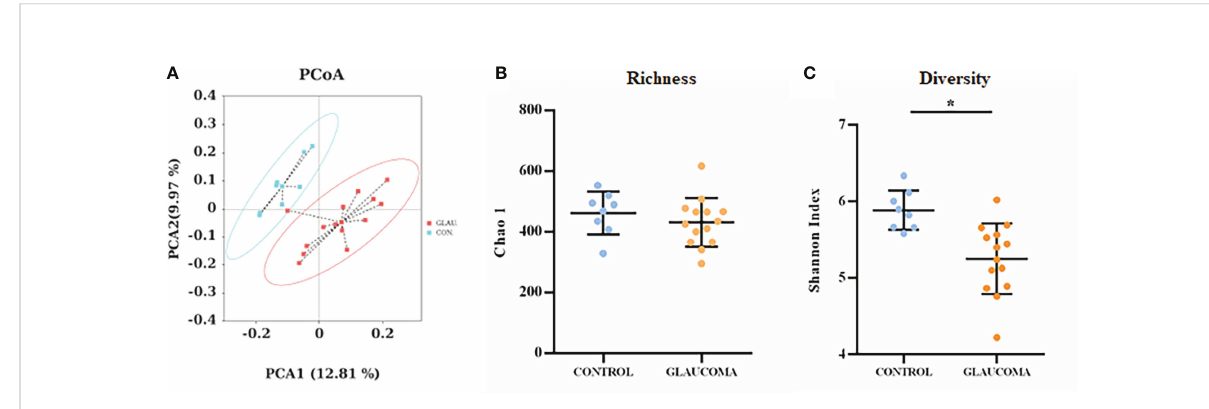
FIGURE 2 Diversity and richness of the gut microbiota in rats. (A) PCoA score plots based on unweighted UniFrac distance metrics ( b -diversity) in the glaucomatous and control rats. a -diversity at the OTU levels indicated by the Chao 1 index (B) and Shannon index (C) are compared between glaucoma and control groups. *P<0.05. OTU, operational taxonomic unit; PCoA, principal coordinate